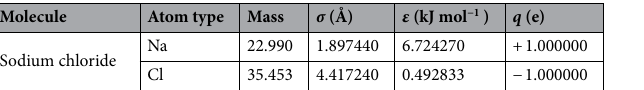
Table 1. Forcefield parameters for sodium chloride 29